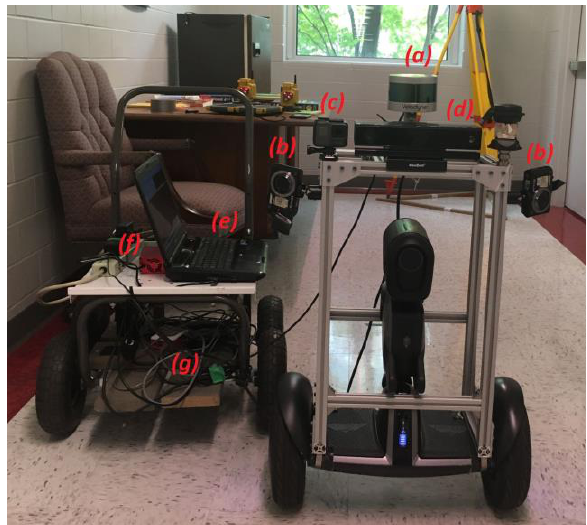
Figure 2. Sensors: a) Velodyne VLP-16 LiDAR, b) Casio, c) GoPro, d) Microsoft XBOX Kinect 360 Sensor; Hardware: e)